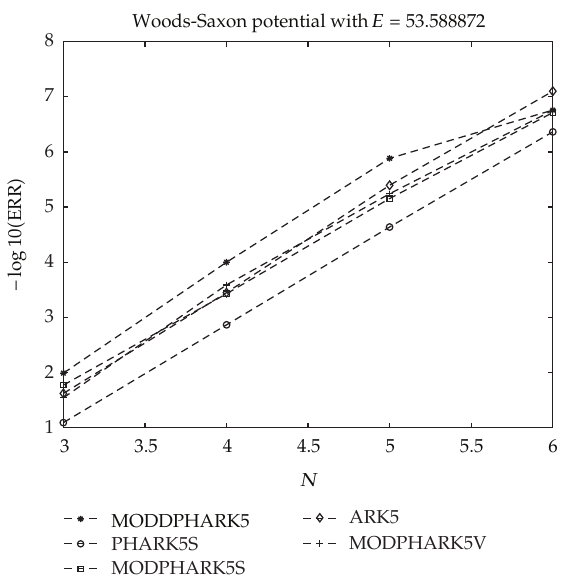
Figure 1: E ffi ciency curves for E (cid:7) 53 . 588872.